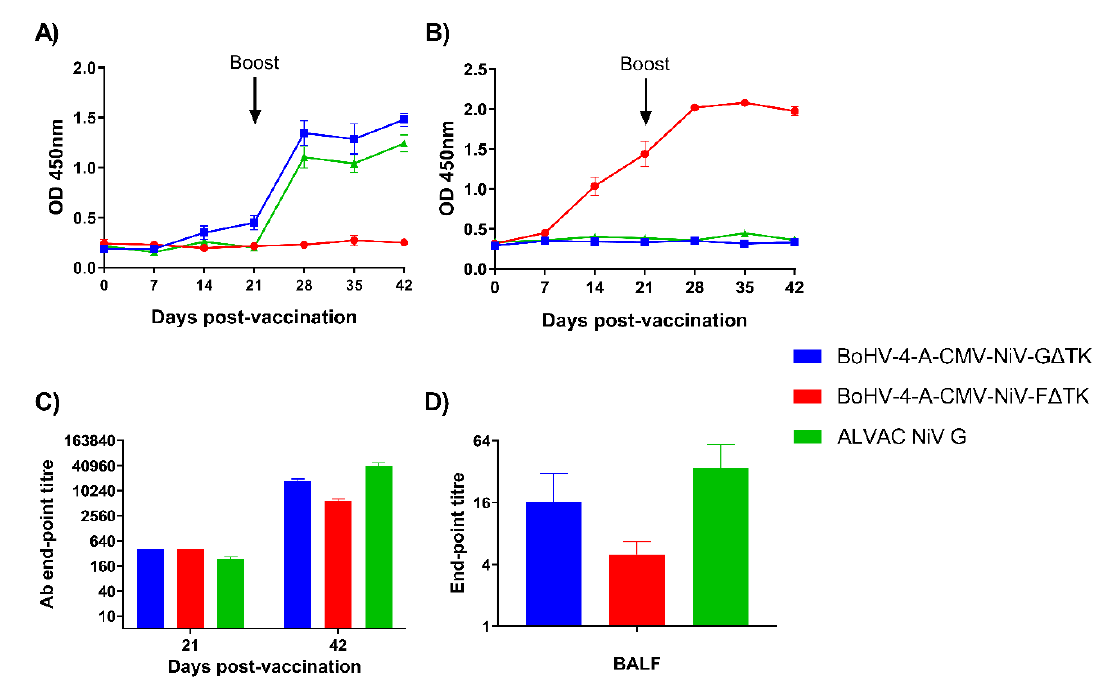
Figure 3. Evaluation of Nipah virus (NiV) antigen-specific antibody responses following immunization of pigs with BoHV-4 vectors. Pigs were immunized with BoHV-4-A-CMV-NiV-G ∆ TK, BoHV-4-A-CMV-NiV-F ∆ TK or ALVAC NiV G on 0 (prime) and 21 (boost) dpv. Recombinant NiV sG ( A ) and NiV mcsF ( B ) proteins were used in ELISAs to assess antigen-specific antibody responses. NiV G or F specific-antibody endpoint titers for the respective groups were measured in sera collected on 21 and 42 dpv ( C ) and in BAL fluid (BALF) collected on 42 dpv ( D ). Mean data ± SEM are shown for each vaccine group.